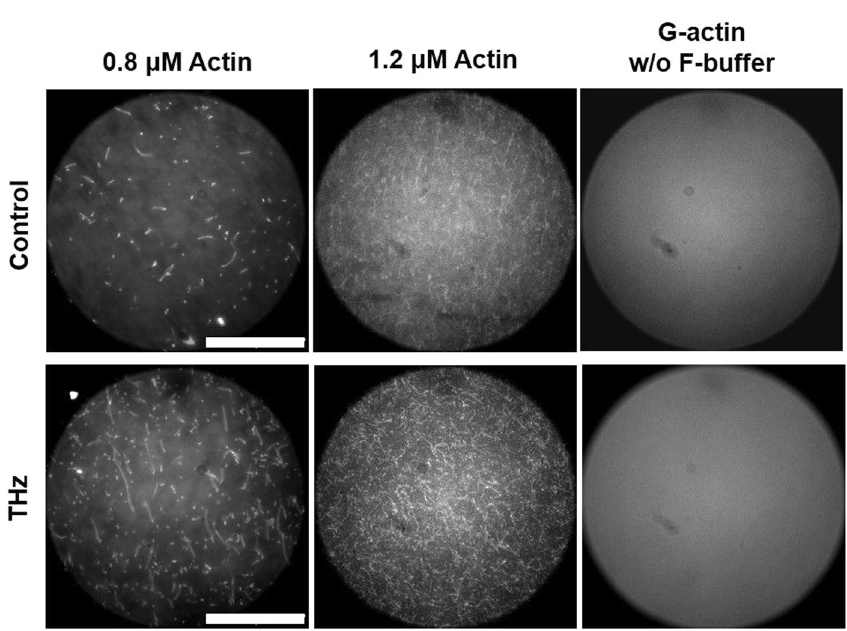
Figure 3. Observation of filamentous actin using the F-actin probe SiR-actin and a fluorescence microscope. G-actin solutions (1.2 μ M and 0.8 μ M) were polymerized by adding F-actin buffer with or without the THz irradiation (THz or Control, respectively) for 20 min. Then, actin filaments were stained with SiR-actin and observed under a fluorescence microscope. As a negative control, the G-actin solution without initiation of polymerization was stained with SiR-actin and subjected to microscope observation. Bar: 50 μ m. More details are described in the Materials and